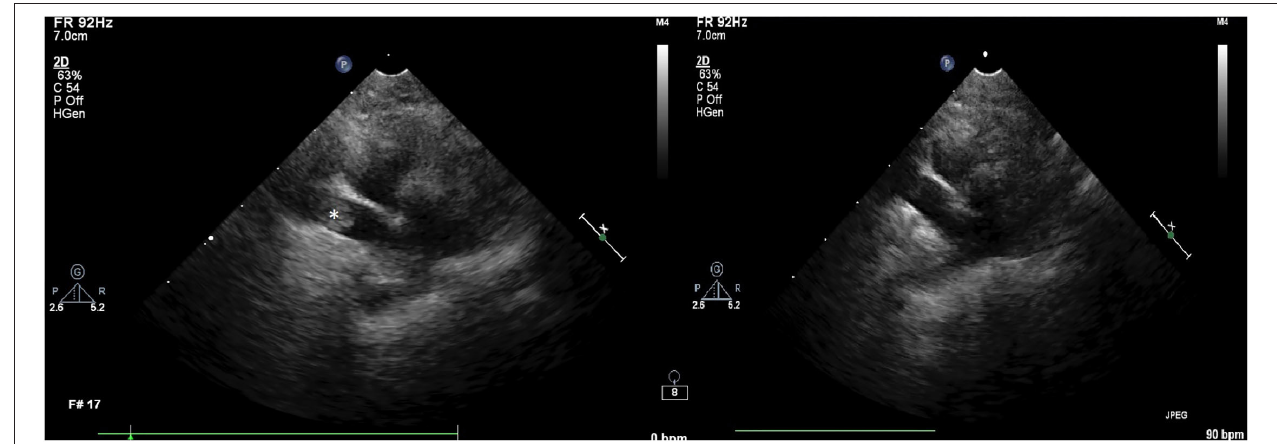
FIGURE 1 | Two-dimensional (2D) right parasternal echocardiographic image on first examination (left) showing the presence of a thrombus (noted by the *) and repeat image (right) showing successful